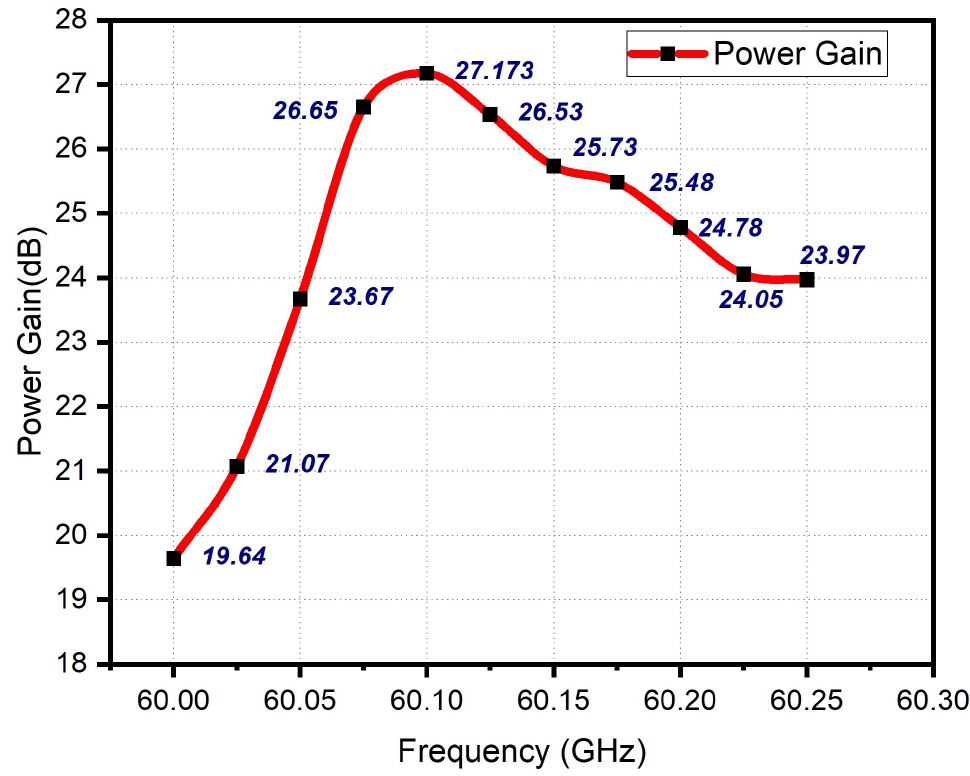
Figure 7. Plot of output power gain vs. input RF signal frequency. The Fourier transform (FT) of the multi-cavity RRSC Klystron’s output RF signal is shown in Figure 8. The maximum RF output signal is achieved at the central frequency of 60.1 GHz.